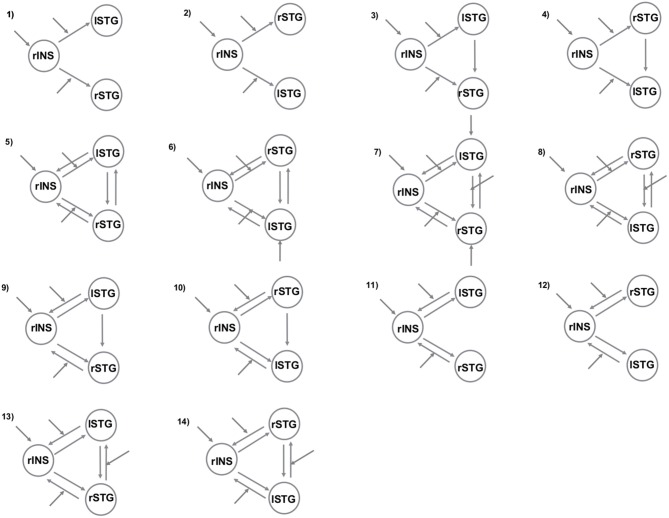
The models tested with Bayesian model selection (BMS). The patterns of modulatory influences of anger on connectivity among right insula (rINS), left STG (lSTG), and right STG (rSTG).